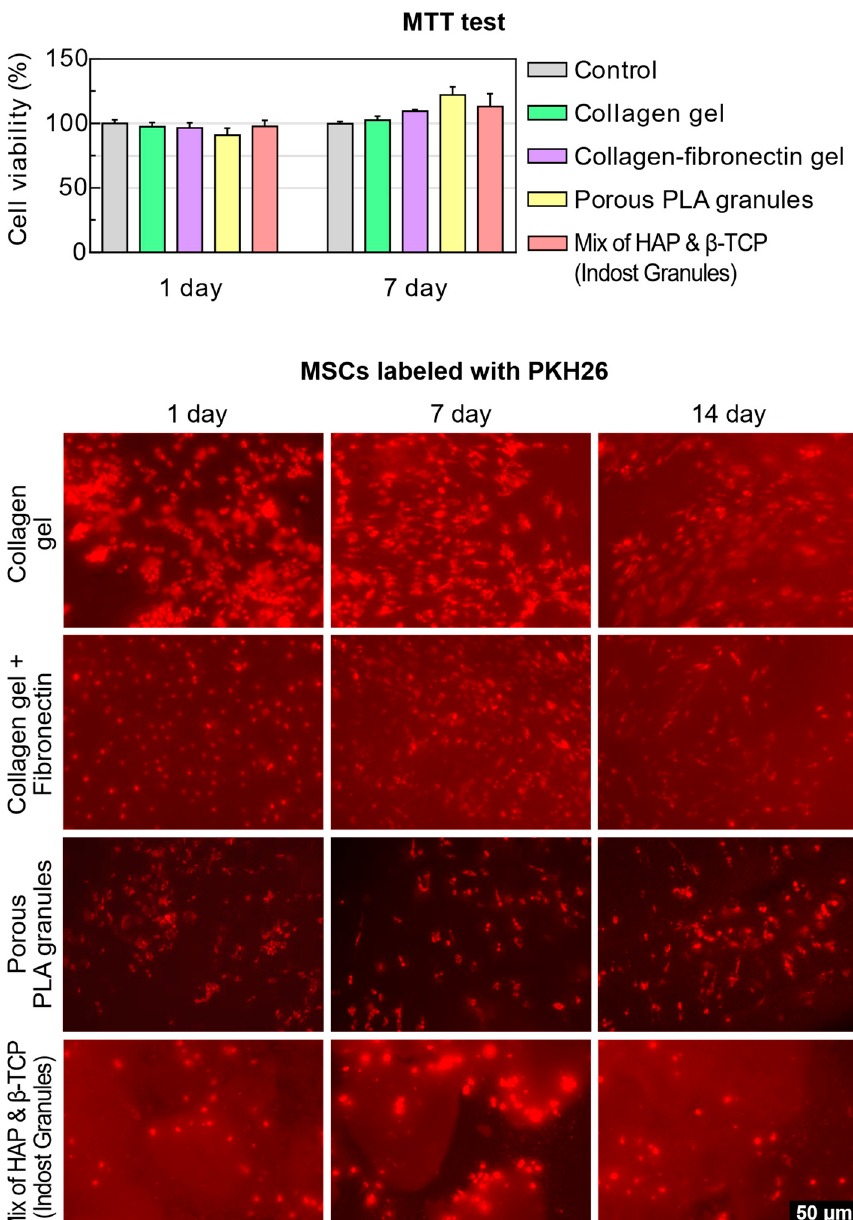
Figure 3. Cell viability and cell adhesion on the materials’ components.